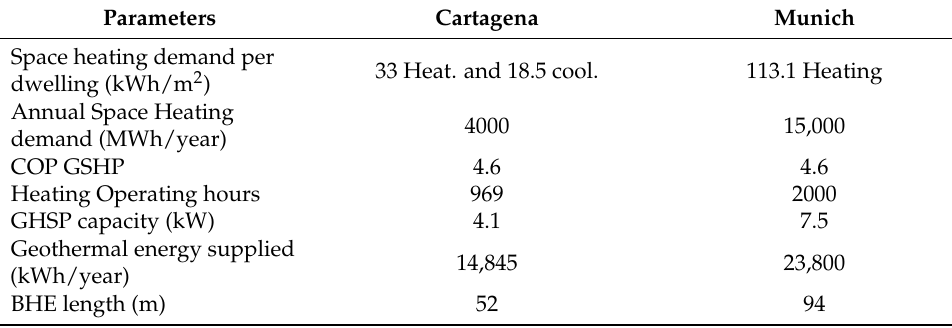
Figure 4. Annual energy demand of the reference dwelling in Cartagena ( left ) and Munich ( right ). Table 2. Energy demand and characteristics for